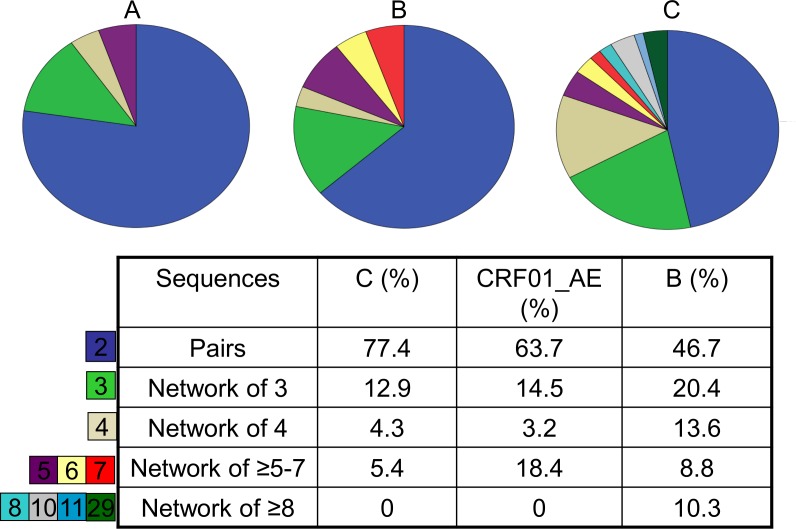
Differences in the distribution and proportions of pairs and larger cluster size for HIV-1 subtypes; HIV-1 C subtype (A), CRF01_AE subtype (B) and B subtype (C) (excludes singletons).